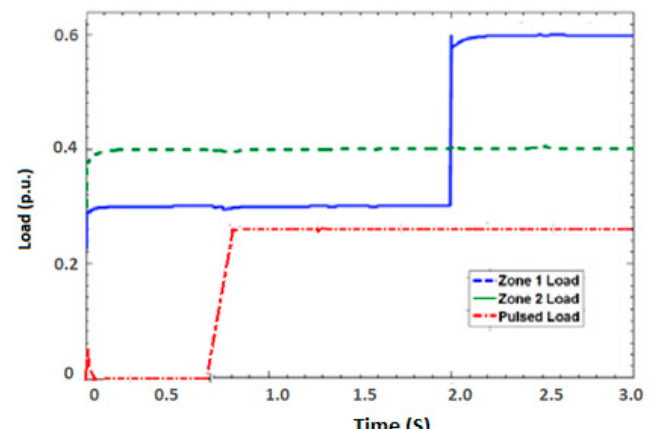
Figure 11. Load changes in the case study.